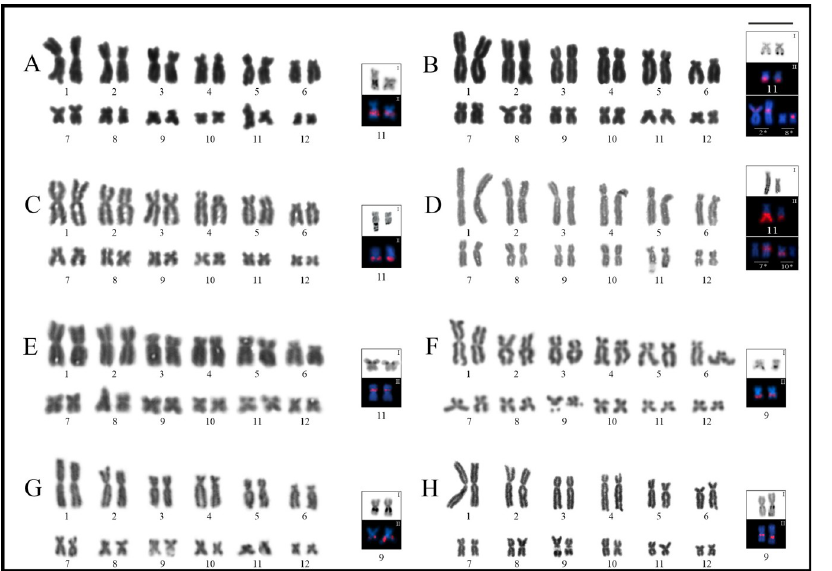
jordani . B. T . helioi . C. T . dibernardoi . D. T . typhonius . E. Itapotihyla langsdorffii . F. Osteopilus septentrionalis . G. Os . vastus . H. Dryaderces pearsoni . Squares show chromosomes bearing the NORs after silver staining ( I ) and with FISH using a 18S DNA probe ( II ).